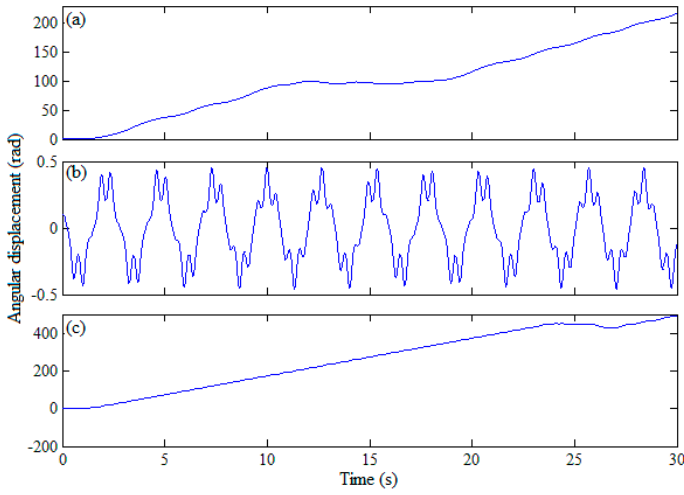
Figure 6. Numerical simulation: ( a ) ω = 10, μ = 0.02; ( b ) ω = 14, μ = 0.04; and ( c ) ω = 20, μ = 0.06.